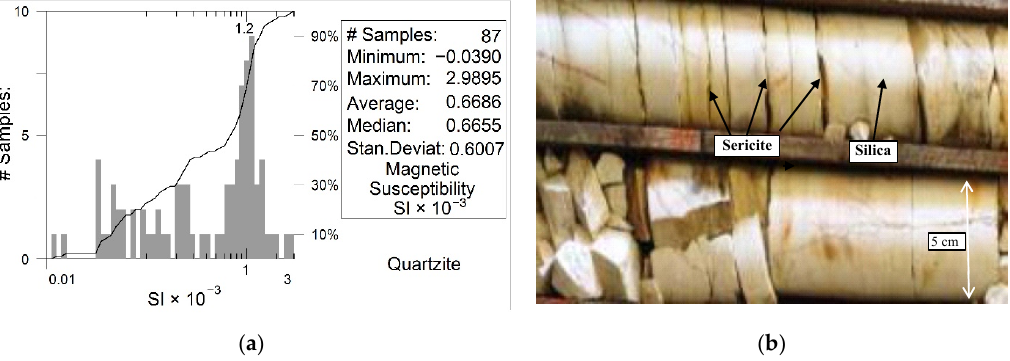
Figure A3. Quartzite. ( a ) Statistics and histograms of the magnetic susceptibility measurements. ( b ) Core samples picture.